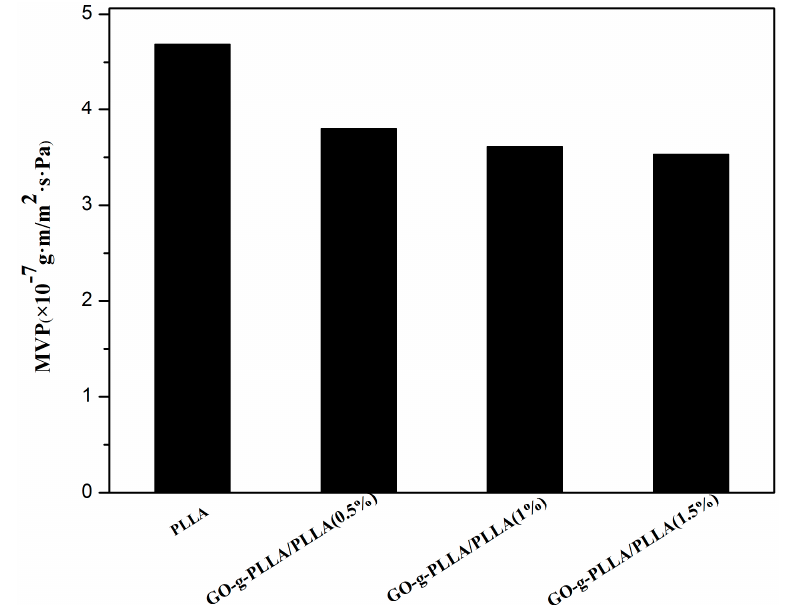
Figure 12. PLLA and GO-g-PLLA/PLLA Water Vapor Permeability (WVP) results.